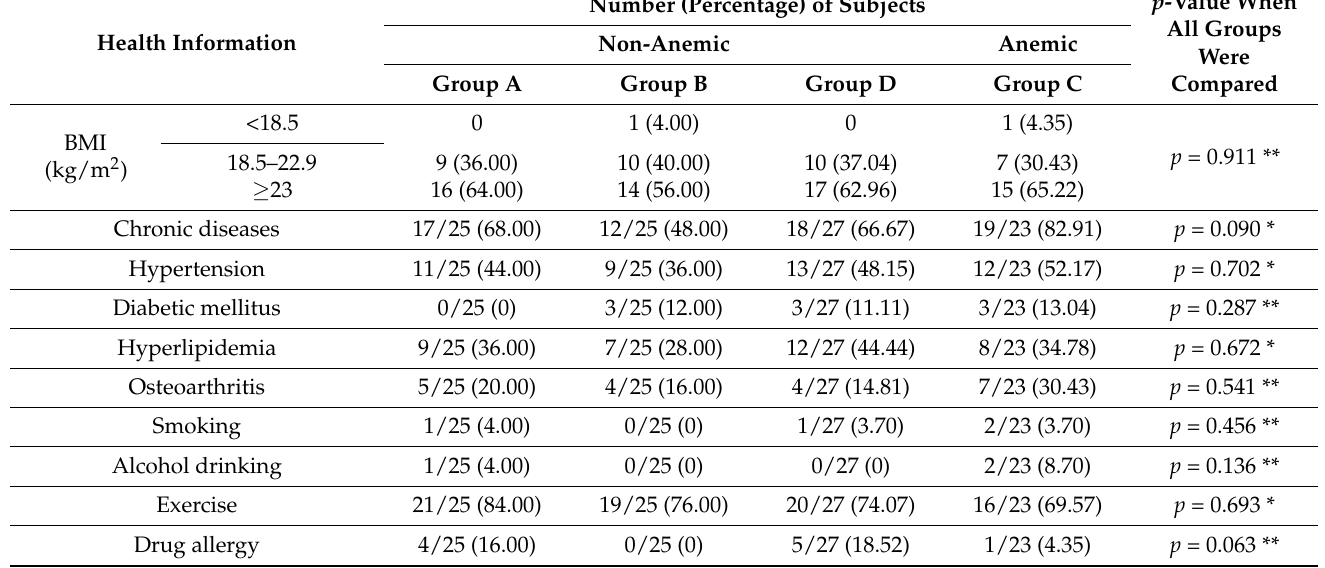
Table 2. Biographic information of subjects in groups A, B, D and C before the study. Non-anemic elders consumed a WR drink (2 mg iron/100 mL serving) (group A), IR drink (15 mg iron/100 mL serving) (group B) and IR drink (27 mg iron/100 mL serving) (group D), while anemic elders consumed the IR drink (15 mg iron/100 mL serving) (Group C). Data are expressed in absolute numbers and percentages (blanket). * Pearson chi-square test, ** Fisher’s exact test ( p < 0.05) when members of the same group were